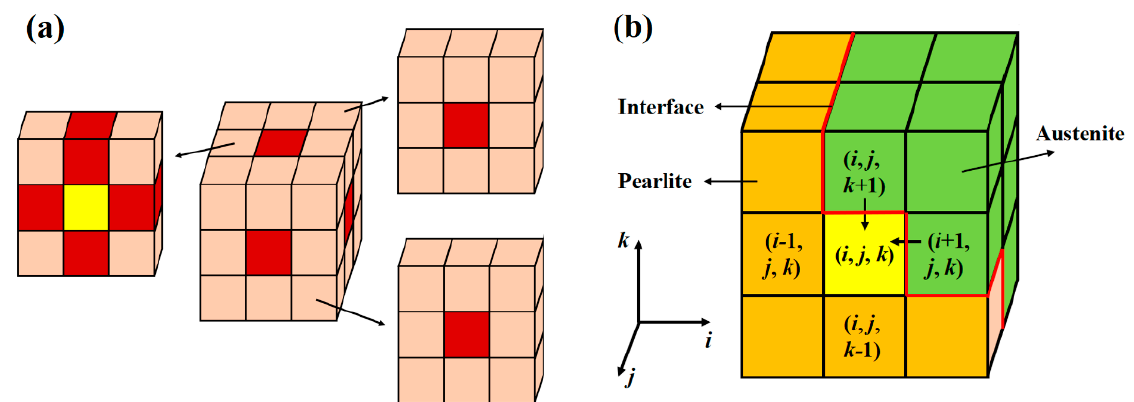
Figure 4. Schematic diagram for the 3D cellular automata cells. ( a ) The von-Neumann neighborhoods; ( b ) the evolution of the cells for the pearlite to austenite transformation process.